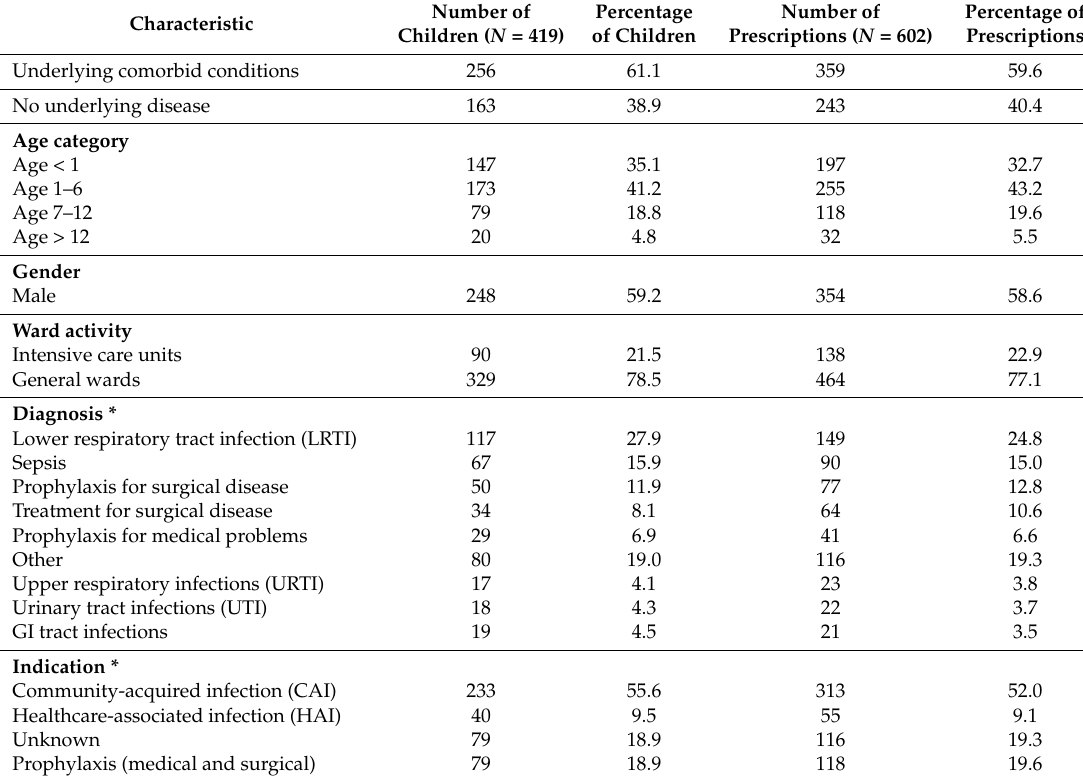
Number of Percentage Number of Percentage of Children ( N = 419) of Children Prescriptions ( N = 602) Prescriptions